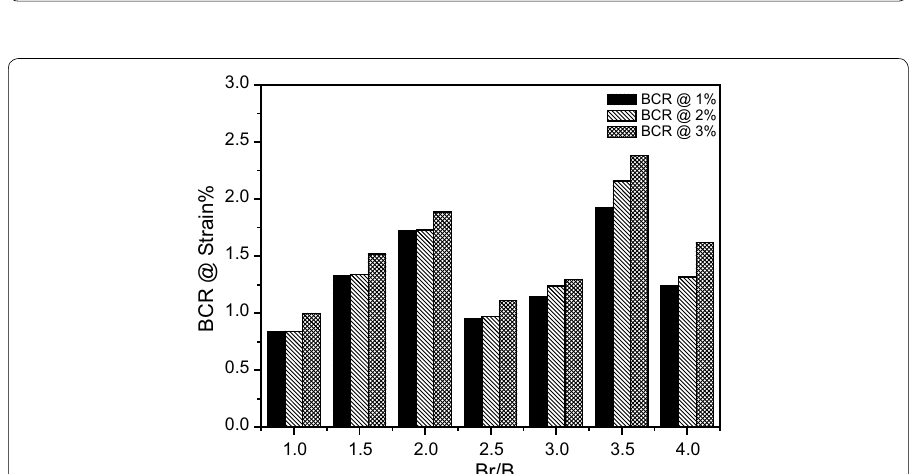
Fig. 10 Effect of size of reinforcement on the bearing capacity